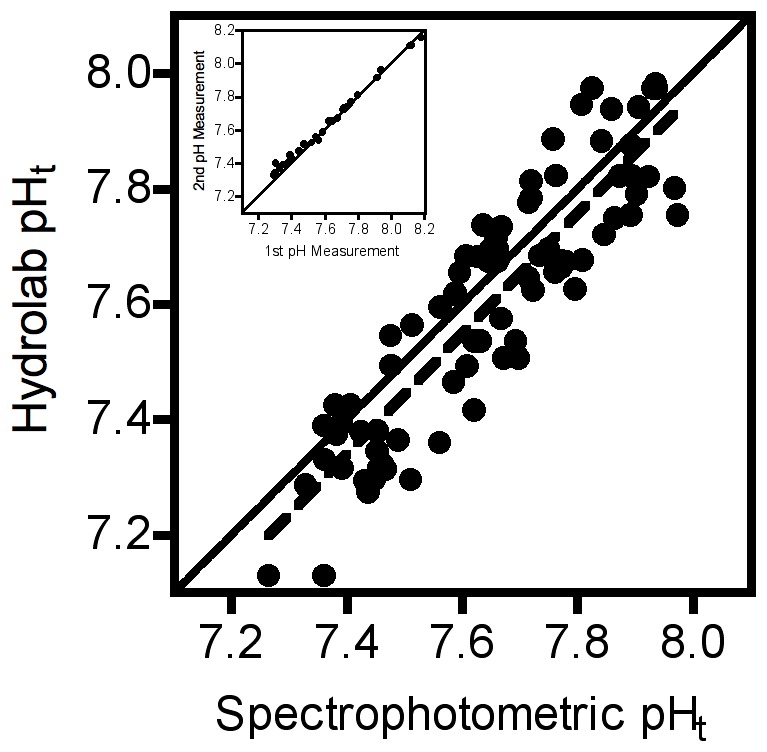
Relationship between pH of water samples measured using spectrophotometric methods and pH measured in situ with an electrochemical probe at the time of water collection.Inset: repeatability of spectrophometric pH measurements. Solid lines: identity relationship. Dashed lines: lines of best fit from linear regression.